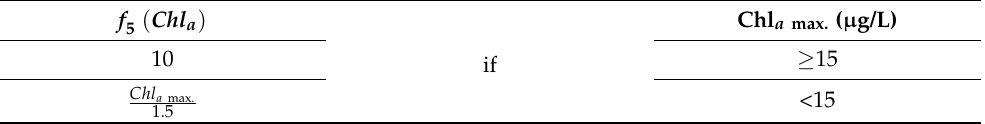
Table 5. The ranges used to assign values for chlorophyll a .